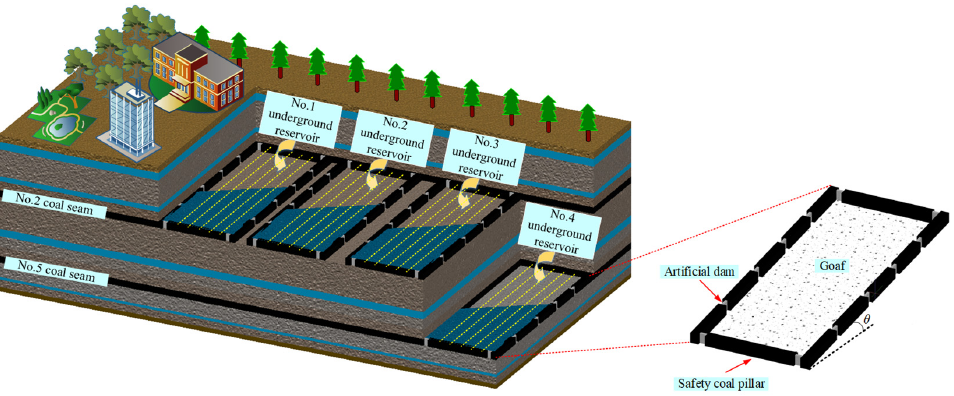
Figure 1. Structural diagram of an underground reservoir in a coal mine.